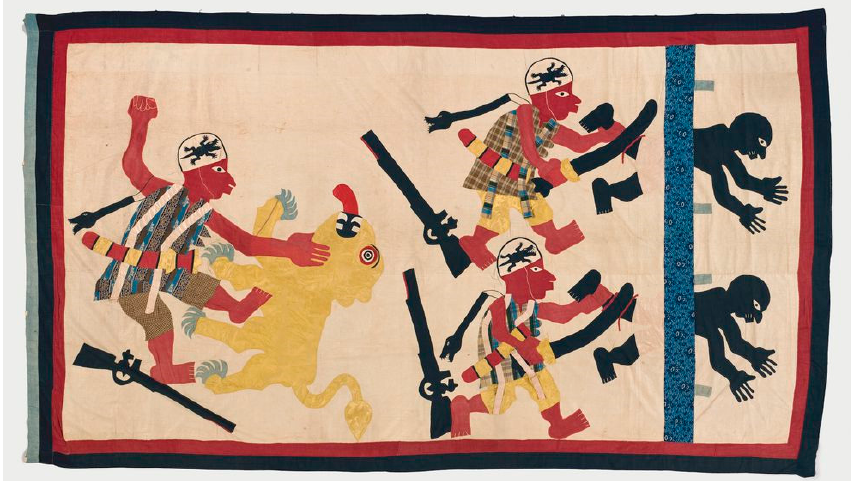
Figure 13. In this flag, a woman on the left is shown fighting a lion with her bare hands, a fist raised over head to deliver a final blow. The lion is on his back on the ground with his tongue sticking out (suggesting death). Two other women, armed with rifles and sabers, are depicted in identical poses, in the midst of cutting off the legs of their enemies, who are depicted in dark blue- black skin tone, in contrast to the reddish brown of the Dahomean warriors. The women warriors wear white bonnets with a lizard blue symbol and white scarves or adornments which could be strings of cowrie shells. Their tunics are appliqued with a print cloth, blue and brown plaid. A stripe of blue flowered print runs vertically down the right edge of the scene, bisecting the enemy figures vertically at the waist. This placement seems deliberate. Are they being shown as crossing a blue line, perhaps crossing the water? In which case, the warriors are capturing them, rather than killing them, perhaps binding them at the ankles to prevent their fleeing. The lion may repre- sent the kingdom of Oyo or another neighboring kingdom with which Abomey was at war. Cot- ton and silk, 338 × 185 cm. 71.1930.54.912 D Image courtesy of the Musée du Quai Branly. In the years that follow, the Maison Régis dramatically increases palm oil production with the support of the King. In 1847, the Regis brothers had made 400,000 francs. In 1854, Victor had brought in 1,000,000 (Masson 1906). It is during this era that the name Régis takes on more prominence in Marseille. In a history published by the Chamber of Com- merce, Victor Régis is considered one of the most influential and wealthiest maritime mer- chants in the city (Caty and Richard 1986, p. 150). To put this in context, Marseille in 1870 is the fourth largest port in the world (by tonnage) behind London, Liverpool, and New York (Caty and Richard 1986, p. 45). In 1855, Victor won a gold medal at the first Universal Exposition for the collection he sent from the various comptoirs (trading posts) (Masson 1906, p. 375). In the 1860s, Victor Régis had enough wealth to build the Grand Hotel de Noailles in Marseille. On its central façade, holding up the pediment of the building are the heads of two African women, crowned with fruit. Floating above them is the figure of Mercury, the patron god of commerce. See Figure 14. Nowhere else in Marseille are African women represented in the city’s architecture, though such mascarons are widespread in Nantes and Bordeaux—the two cities regarded as French ports of the slave trade (Santacroce 2015). And this remarkable design goes un- mentioned in many public descriptions of Marseille’s nineteenth century architecture and contemporary tourist sites. In 1862, when he built the hotel on the grandest avenue in Marseille, Victor was telling the world where his wealth came from—it came from African women.